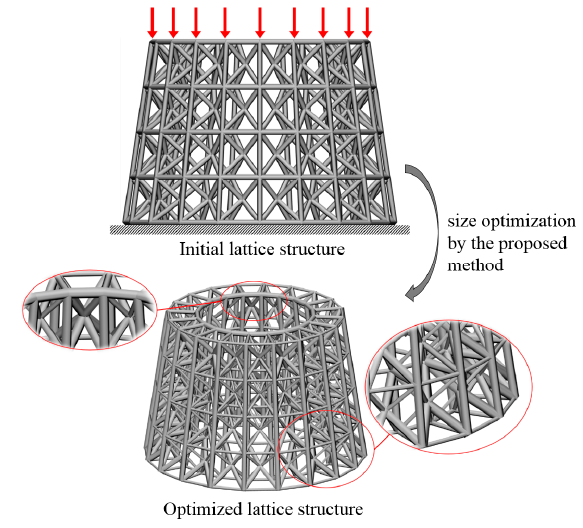
Figure 22. Boundary conditions and result of the optimization problem.